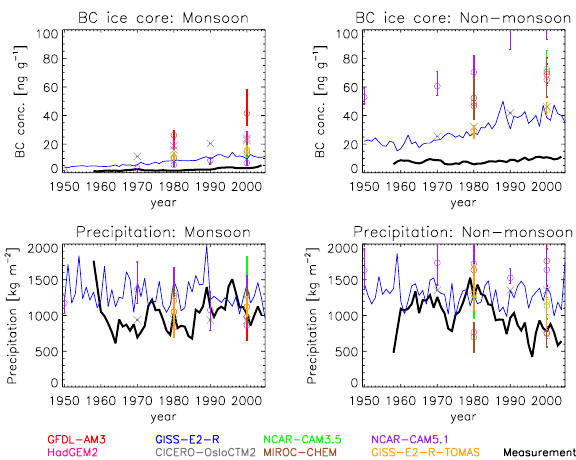
Fig. 14. Temporal trends of 5-yr running average of BC snow con- centrations [ng g − 1 ] and accumulated precipitations [kg m − 2 ] dur- ing monsoon (June to September) and non-monsoon (October to May) seasons at Zuoqiupu. Refer the color scheme and the plotting method to the caption of Fig. 11 and Sect. 4.4 for how the observed precipitation data is prepared. Note that the ACCMIP timeslice sim- ulations for NCAR-CAM3.5 and MIROC-CHEM are